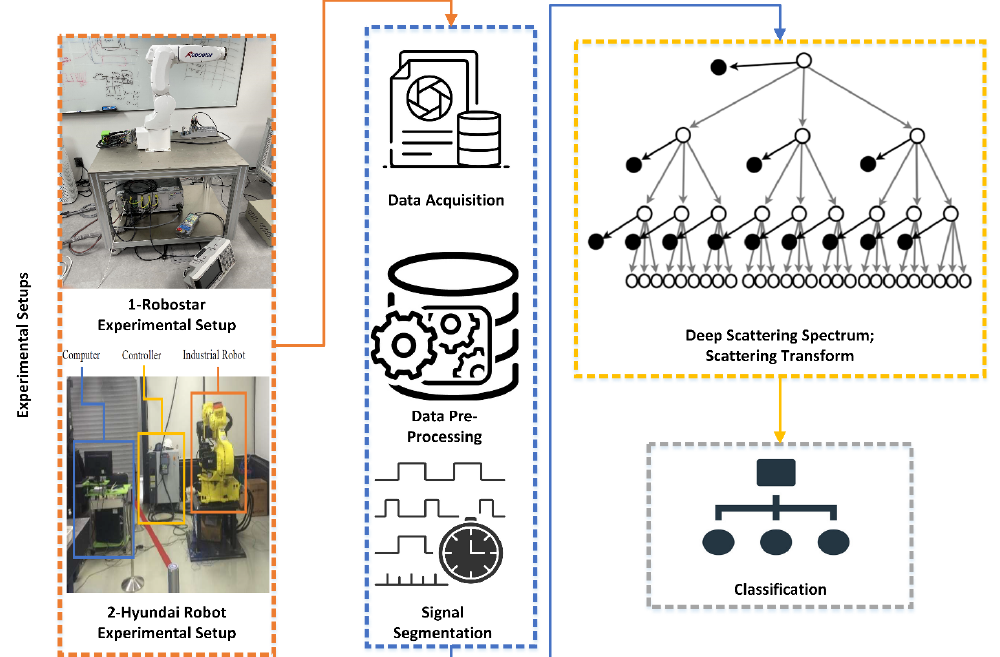
Figure 2. Basic overview of the